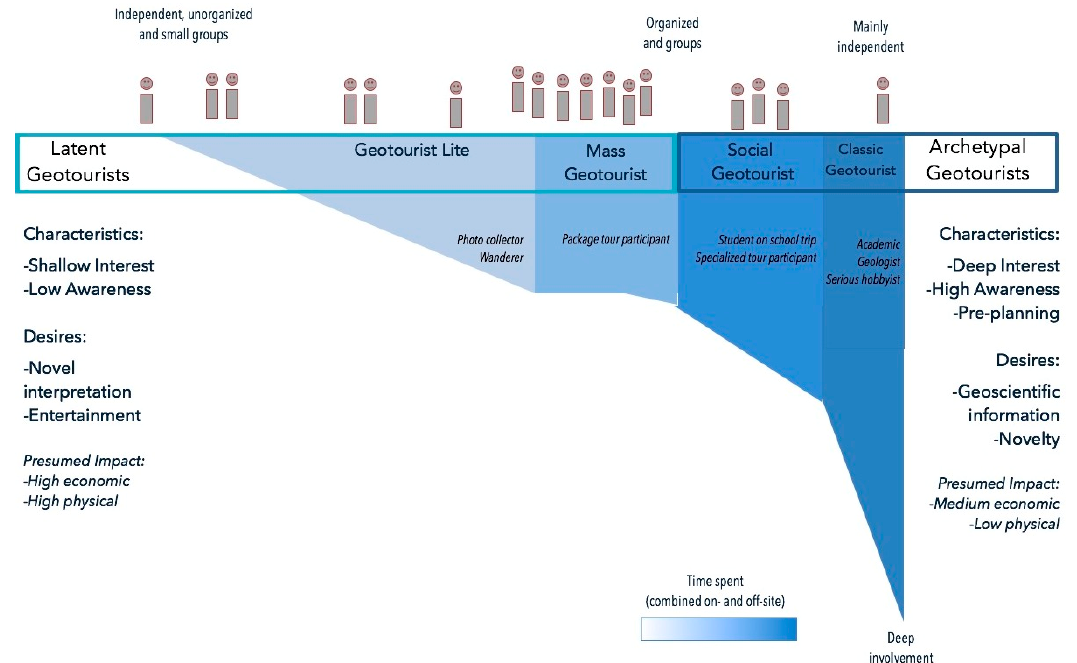
Table 2. Conceptual geotourist categories